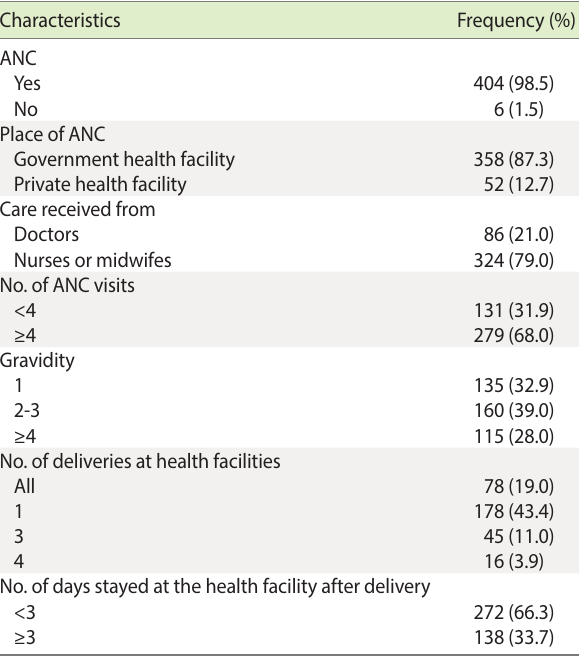
almost all the respondents (n=346, 84.4%) did not have the finan- cial capacity to pay for delivery services (Table